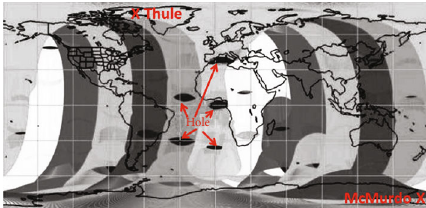
Figure 19: Ground coverage results by 6 COF satellites in 1 revisit